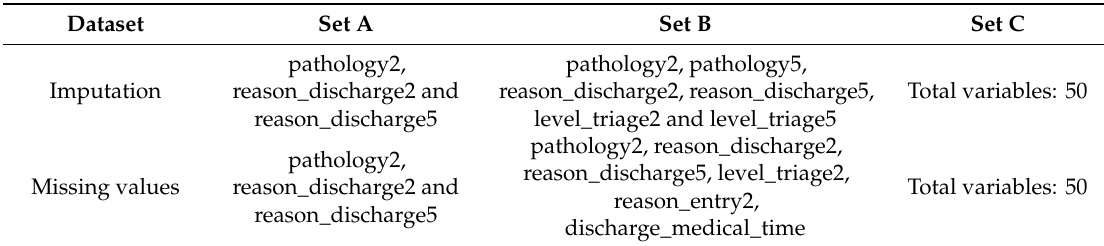
Table 9. Set of variables